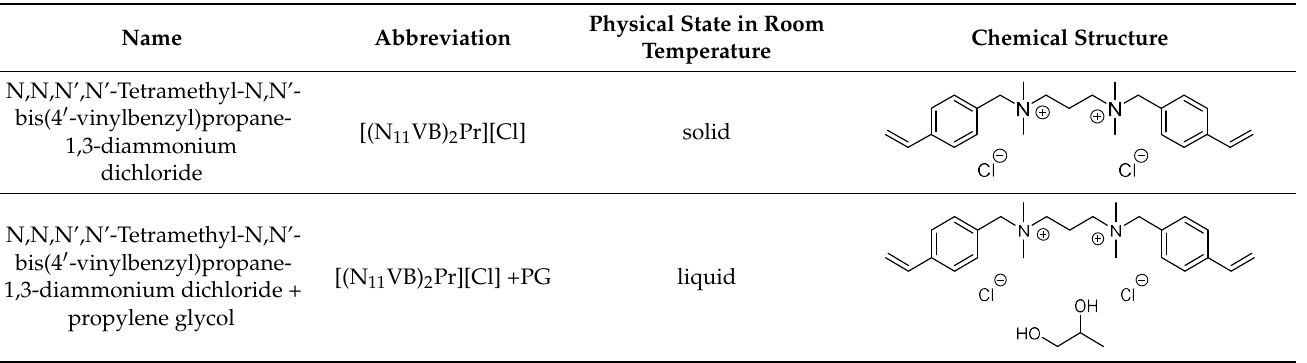
Table 1. Vinylbenzyl-based ionic liquids used in the study.